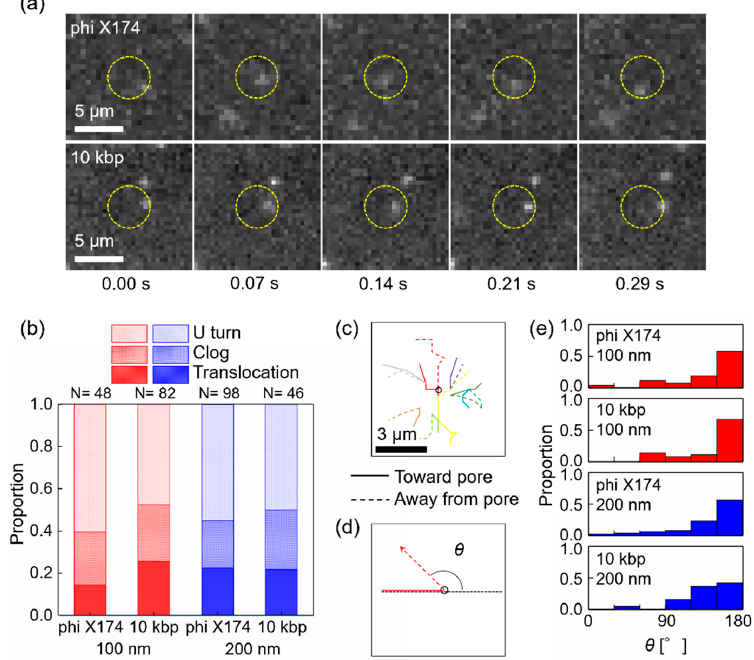
Figure 3. U turn of circular DNA at 100 nm diameter nanopore. ( a ) Two sequences of fluorescence images of a DNA molecule of 10 kbp and phi X174 near nanopore recorded at 14 Hz. Scale bar is 5 μ m. A circular DNA molecule moves toward a nanopore within the region inside the capture radius (yellow circle) by t = 0.07 s, approaches further at t = 0.14 s, and then moves away from the pore after t = 0.21 s. An external bias voltage was 0.3 V (see also Video S3, S4 U turn of circular DNA). The images for 10 kbp and phi X174 were acquired with different CCD cameras, altering the pixel counts/scale bar of 5 μ m (see Materials and Methods). ( b ) Proportion of translocation, clog, and U turn of circular DNA, phi X174 and 10 kbp for 100 and 200 nm diameter pores. Nearly half of DNA U turns. ( c ) Representative trajectories of U turn DNA of 10 kbp. Dotted line shows trajectories moving away